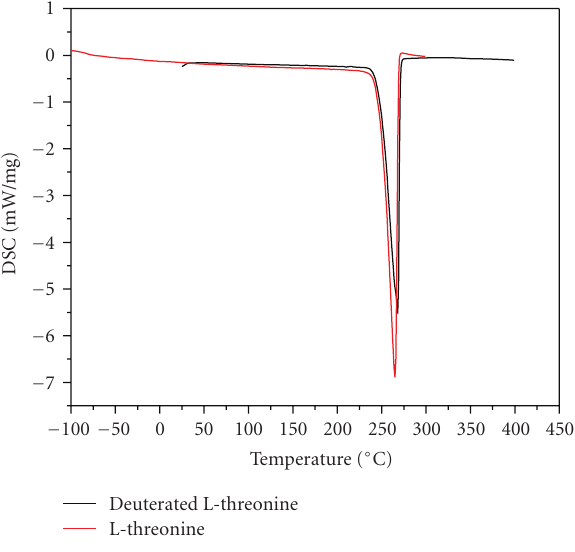
Figure 32: DSC curve of L-threonine and deuterated L-threonine single crystals.